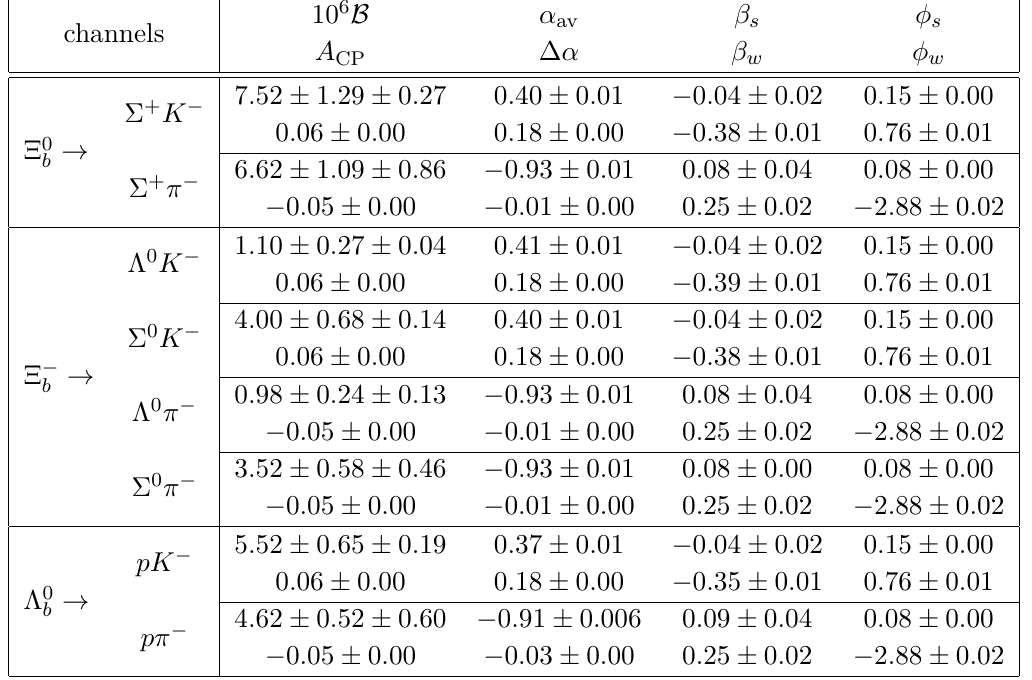
Table 1. Numerical results in B b → B n P , where the first and second uncertainties in the branching ratios come from the bag radius [48] and CKM elements [29],